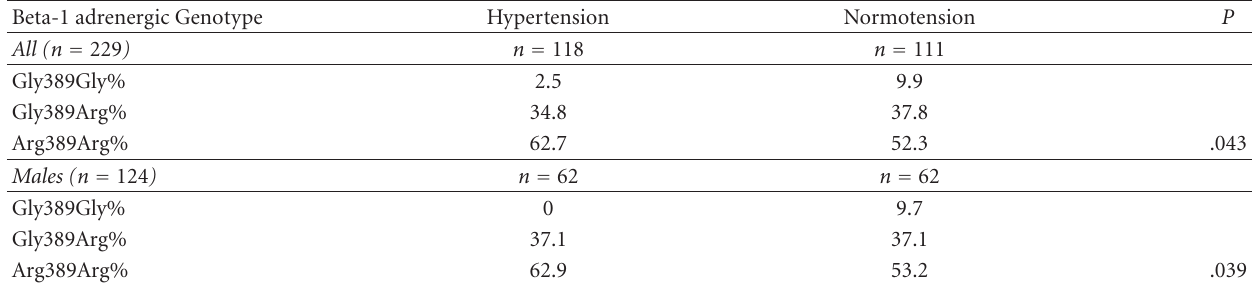
Table 5: Frequency of hypertension in patients with mild obstructive sleep apnea according to Beta-1 adrenergic receptor Arg389Gly